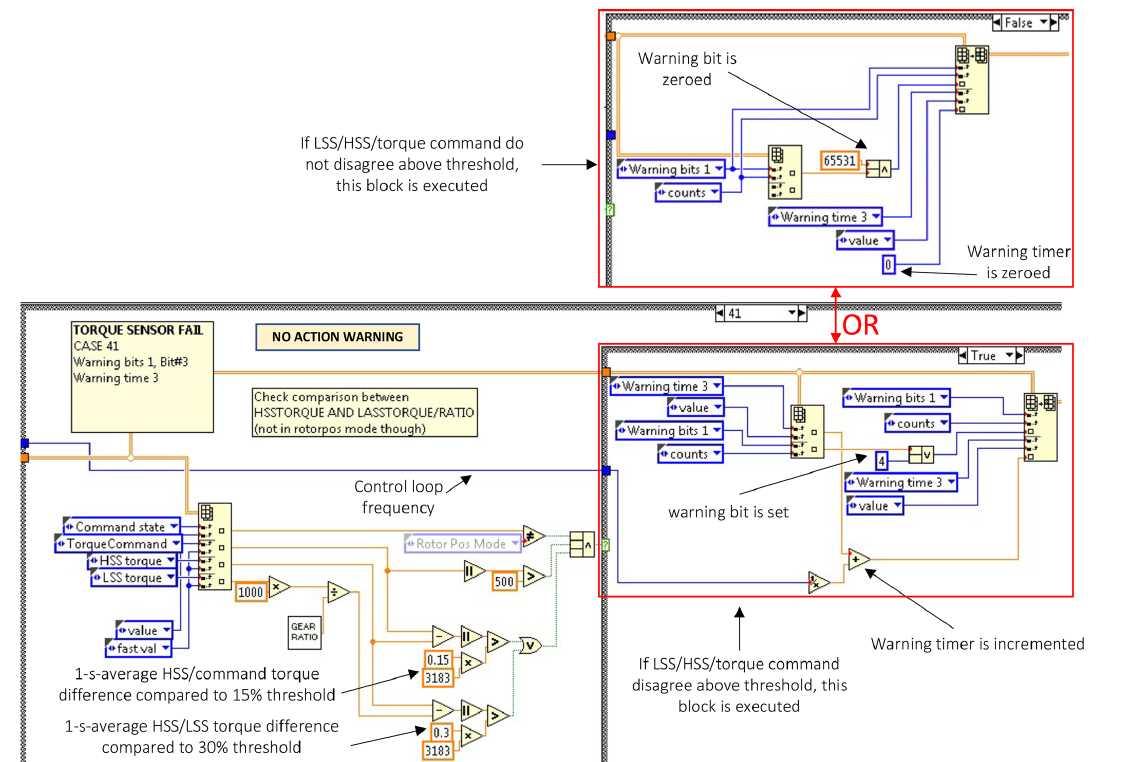
Figure A1. A sample from the FIRC implementation in the CART3 controller, written in LabVIEW. The controller loops through various fault checks. In this sample, it is performing the TORQUE SENSOR FAIL check. If warning conditions exist, it sets the wait mode bit and increments the wait timer. Otherwise, it zeroes the wait mode bit and the wait